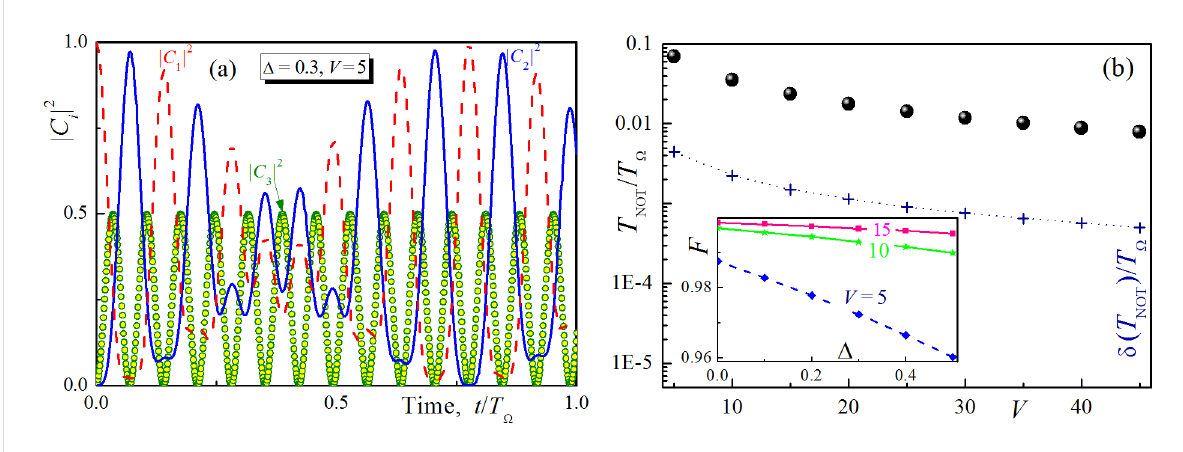
Figure 3: Analytical solution of Equation 7 obtained for Δ = 0.3, V = 5, dashed lines, solid lines, circles and squares are for | C 1,2,3 | 2 (a) and the char- acteristic time of population transfer (dots) as well as the the required time accuracy, δ ( T NOT ), providing 98 percent of transition efficiency (dot line with crosses) versus the degree of coupling between the atom and the magnetic field (b). The inset in (b) shows how the efficiency of the ‘’Not”-opera- tion operation F (determined by | C 2 | 2 at the first maximum) decreases with increasing normalized value Δ for different coupling V